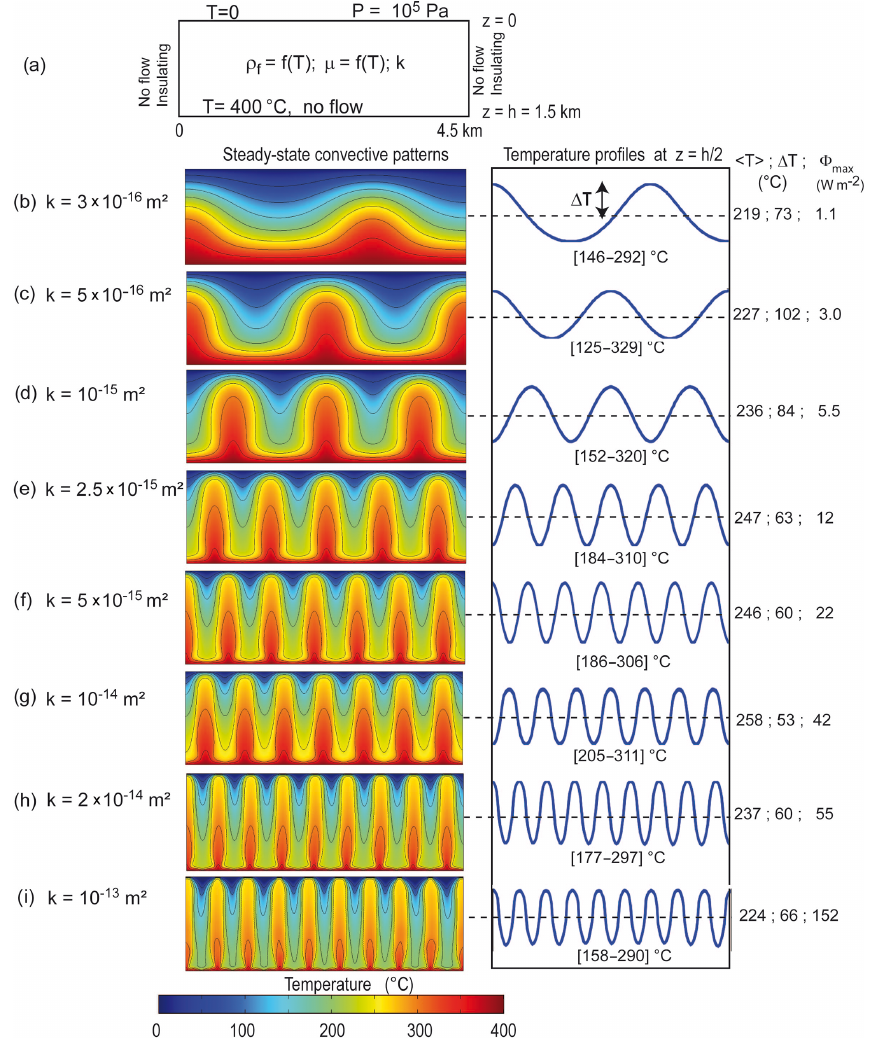
Figure 1. Steady-state temperature fields obtained for different values of the medium permeability. The left column shows temperature fields, and the right column illustrates a horizontal temperature profile at mid-depth. Averaged temperature at mid-depth ( (cid:104) T (cid:105) ), temperature anoma- lies ( (cid:49)T ), and maximum heat flux carried by thermal plumes at the top surface are indicated on the right of each profile. The numerical setup and boundary conditions are illustrated in (a) and detailed in the text. For all experiments, the maximum mesh element size is 20m. Hydrothermal convection (b) is observed for permeability around 3 × 10 − 16 m (a pure conductive regime is obtained for smaller permeabil- ity). The number of upwellings increases with increasing permeability. Above 10 − 13 m 2 , convection exhibits unsteady patterns, including typical Y-shaped and splitting